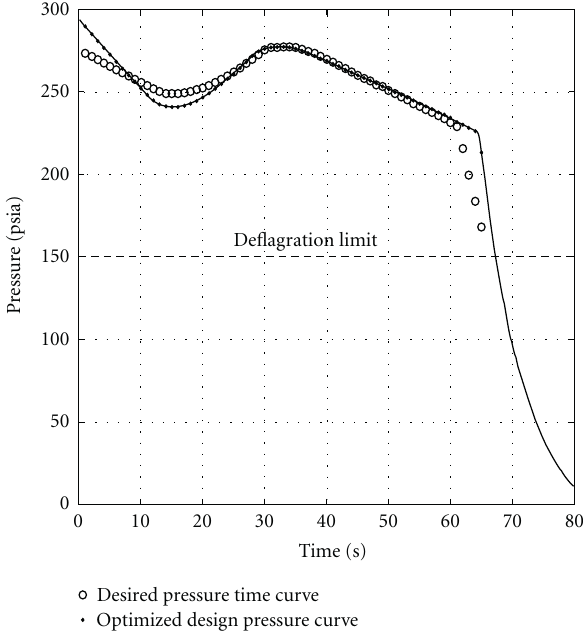
Figure 8: Optimized pressure-time curve for regressive-progres- sive-regressive